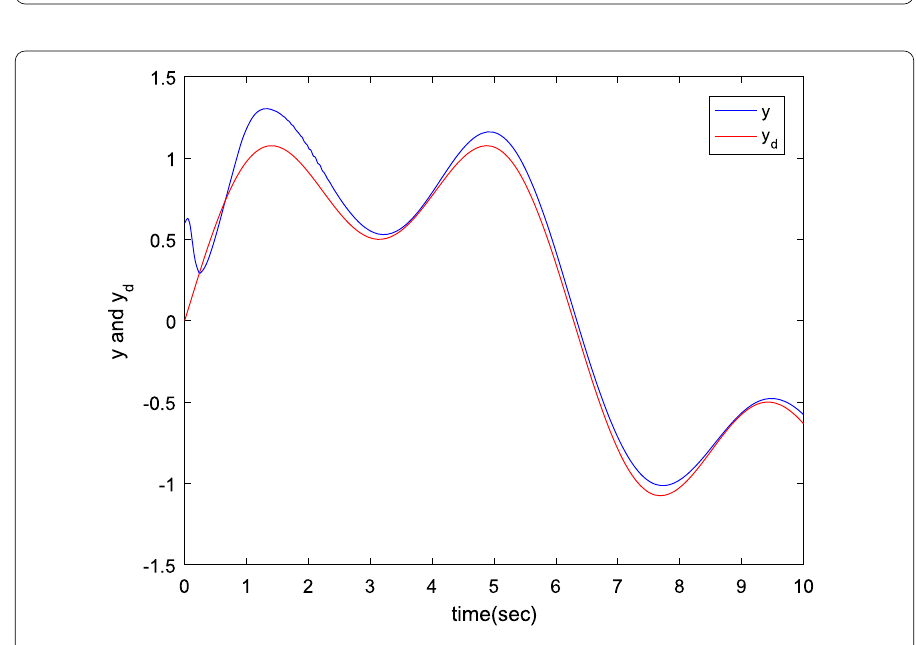
Figure 5 y and y d with ℘ =